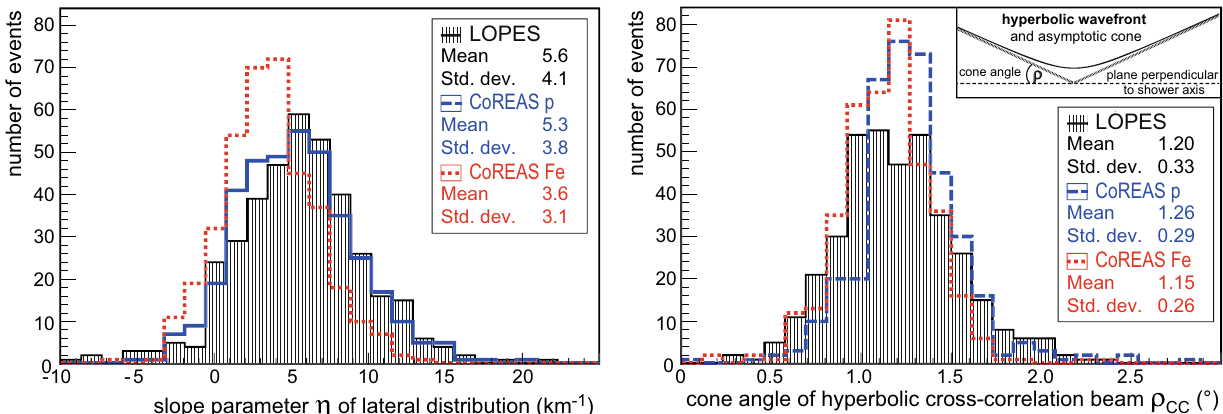
Fig. 13 Comparison of LOPES measurements and the end-to-end CoREAS simulations for KASCADE(-Grande) events: the slope of the lateral distribution η , and the cone angle of the wavefront ρ CC determined by cross-correlation